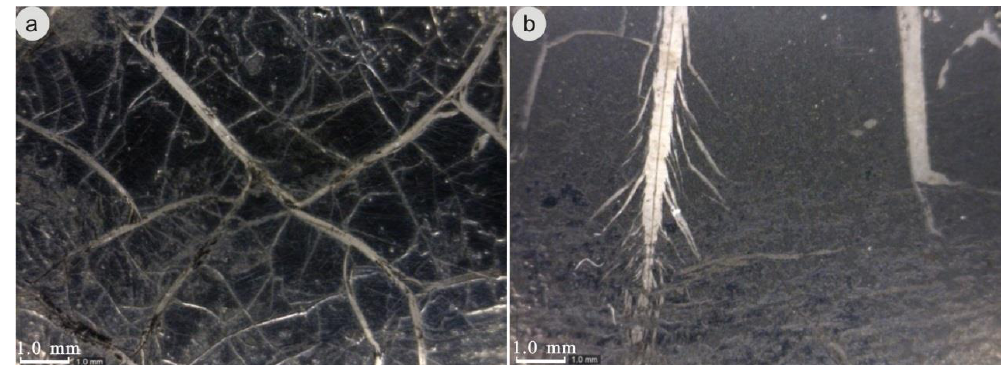
Figure 3. Photographs of coal structure (lateral section) with banded vitrain layers filled with mineral matter, No.3 coal from Songhe coalmine, Liupanshui coalfield of Southwestern China.